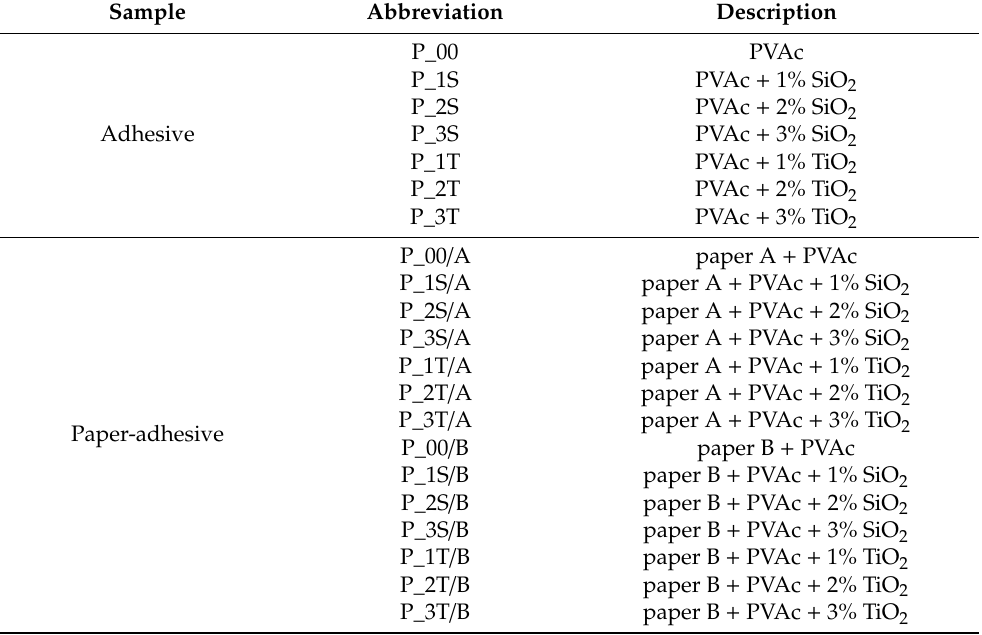
Table 2. List of used adhesive, paper-adhesive and adhesive joint samples.